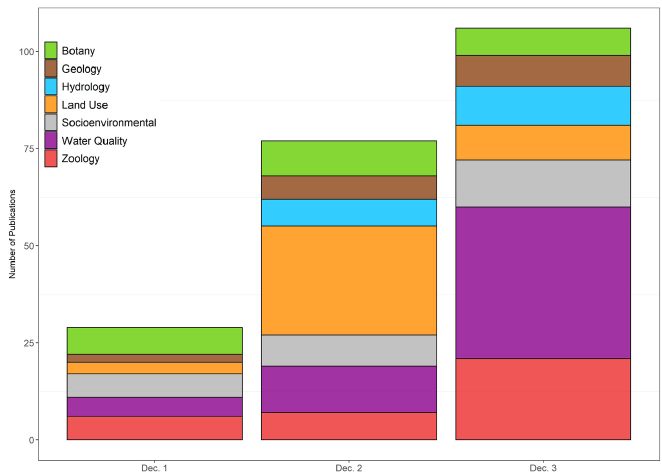
Figure 5. Number (N) of publications on the subjects studied on the seven sub-areas of aquatic ecology in Santa Catarina Island in the last three decades (Green = botany; Brown = geology; Blue = hydrology; Orange = land use and land cover; Grey = socio-environmental; Purple = water quality; and Red = zoology).